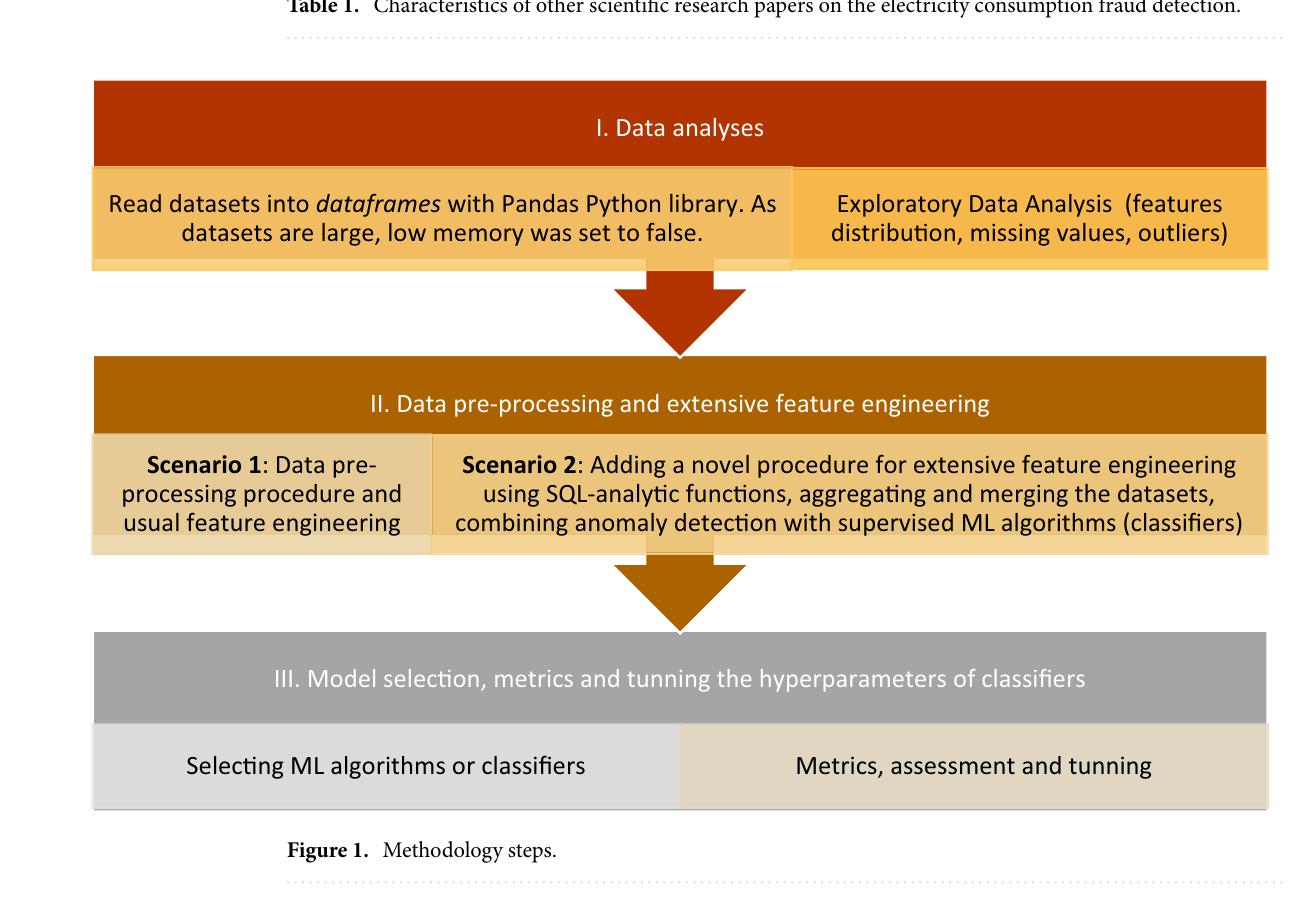
Figure 1. Methodology